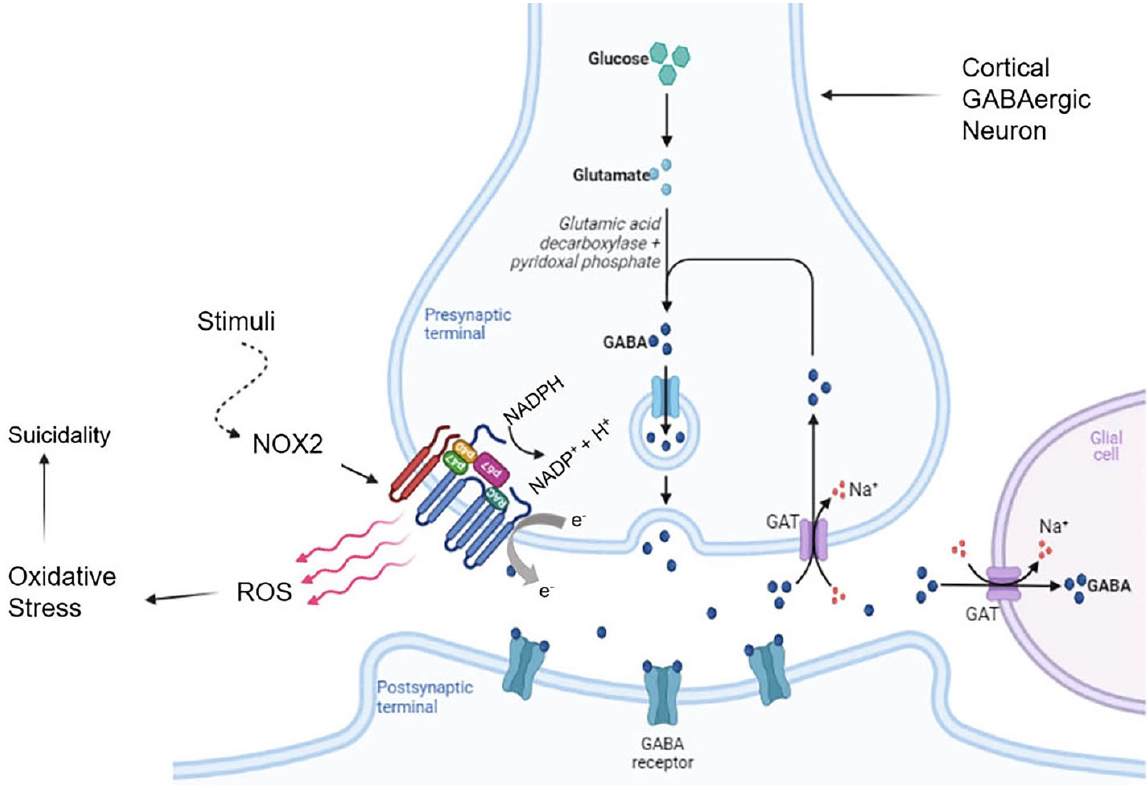
Figure 3. Oxidative Stress and Suicidality: Role of NADPH oxidase 2 in Reactive Oxygen Species production. (Created in BioRender.com (accessed on 2 April 2022)).